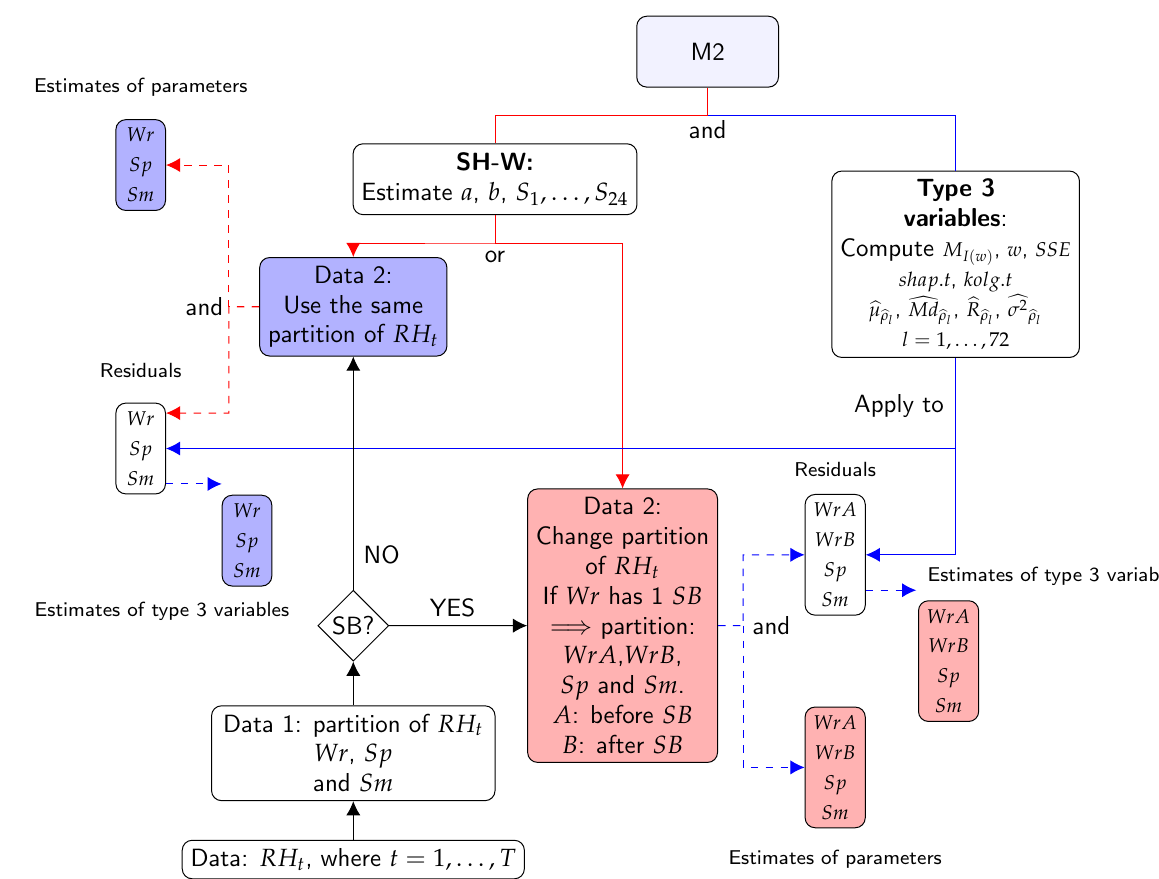
Figure 5. Flow chart for the steps of method 2: Red lines indicate estimated parameters. Blue lines indicate type 3 variables. Solid lines indicate processes. Dashed lines indicate results. The first step divides the different time series according to the climatic conditions ( Wr, Sp, and Sm) (Data 1). The second step organises the time series according to possible structural breaks (SBs) (Data 2). The third step applies the method to Data 2 in order to obtain the estimates of the method’s parameters (first result) and then the residuals from the method. The fourth step consists of applying the formulas for type 3 variables to the residuals (second result). Different boxes display symbols Wr, Sp, and Sm (or WrA, WrB, Sp, and Sm). This indicates that the results correspond to all different parts of the time